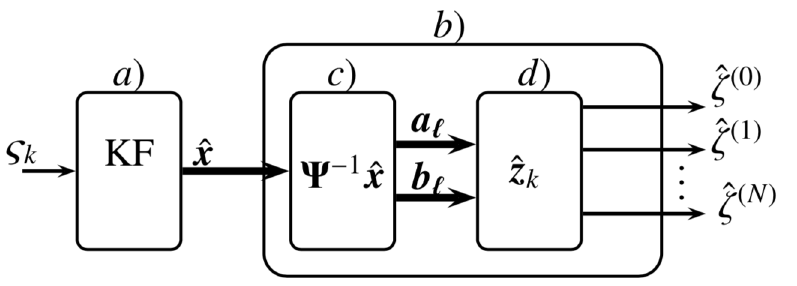
Figure 1. Block diagram describing the proposed methodology to estimate the FCs, DFCs, signal approximation and its derivatives. In ( a ), the Kalman filter is implemented, ( b ) contains two subsec- tions, ( c ) and ( d ). In ( c ) the coefficients with the state estimates provided by Kalman filter and with the state matrix Ψ − 1 are obtained. Finally in block ( d ) Equation (18a)–(18d) is implemented to obtain the approximation signal.